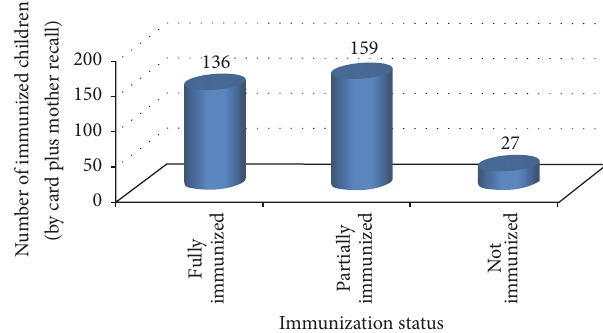
Figure 1: Number of immunized children aged 12–23 months for each dose of vaccine by card only at Mizan Aman town, Bench Maji zone, Southwest Ethiopia 2017.